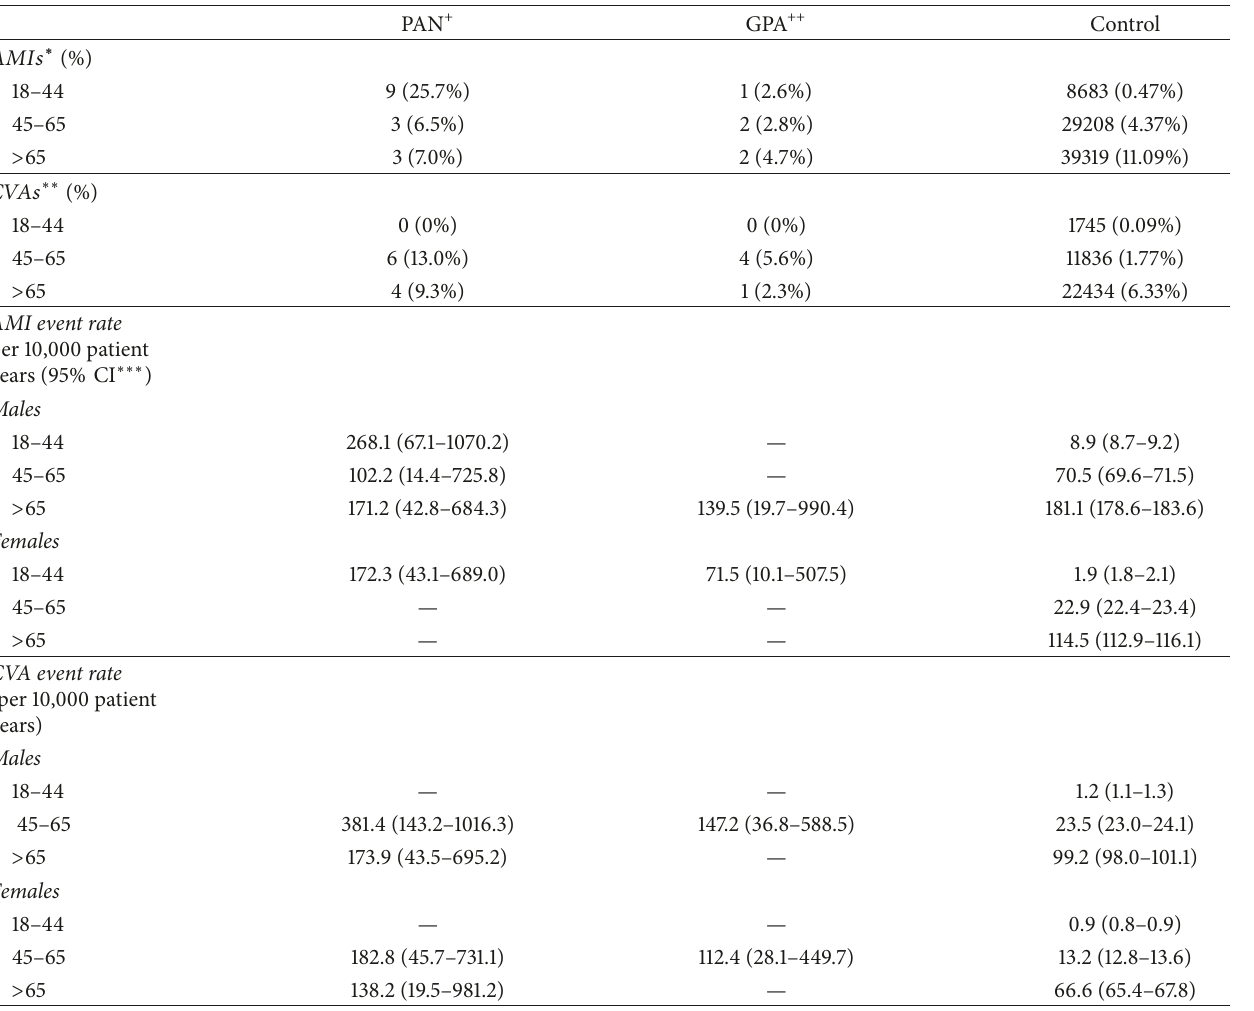
Table 2: Event rates (per 10,000 patient